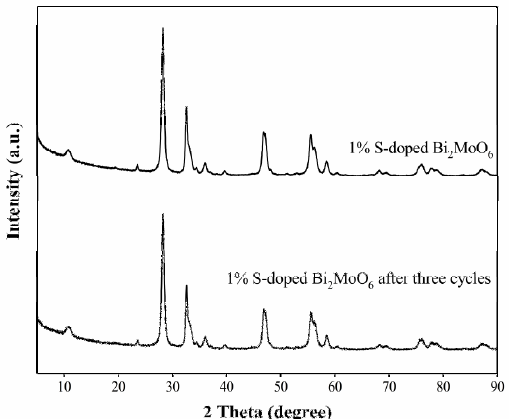
Figure 12. The XRD of 1% S-doped Bi 2 MoO 6 fresh samples and the samples after three photocatalytic experiments.